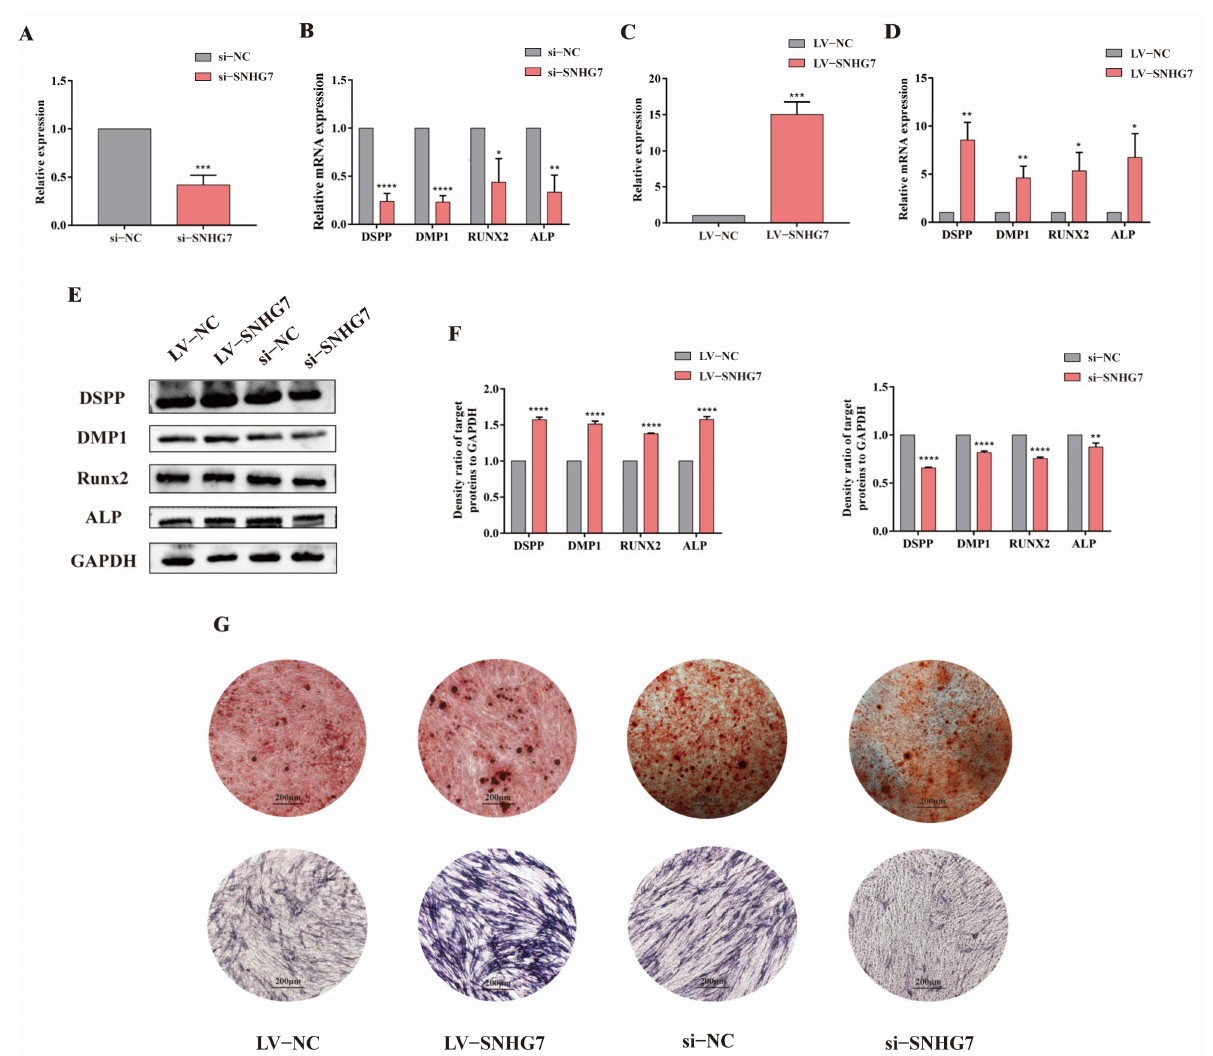
Figure 4. lncSNHG7 promoted osteogenic/odontogenic differentiation of hDPSCs. ( A , C ) The knockdown and overexpression effect of si-lncSNHG7 and LV- lncSNHG7 detected by qRT-PCR. ( B , D ) mRNA expressions of osteogenic/odontogenic genes detected by qRT-PCR after the knock- down and overexpression of lncSNHG7. ( E ) Western blot results showed the expression level of osteogenic/odontogenic proteins decreased in the si-lncSNHG7 group and increased in the LV- lncSNHG7 group after mineralization. ( F ) The density ratio of target proteins to GAPDH. ( G ) ARS and ALP staining after the knockdown and overexpression of lncSNHG7. The data were represented as means ± SD for each group: * p < 0.05, ** p < 0.01, *** p < 0.001, **** p <